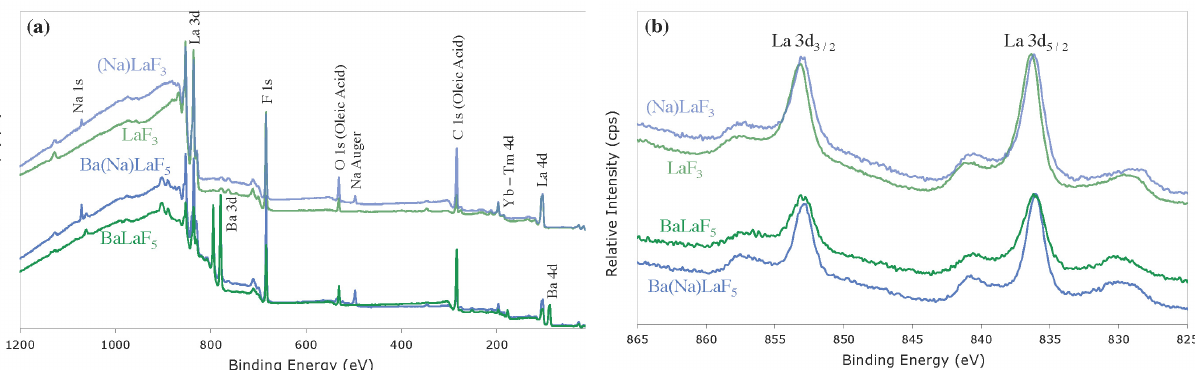
Figure 4. XPS survey scans of ( a1 ) (Na)LaF ( pale Blue ); ( a2 ) LaF ( pale Green ); 3 3 ( a3 ) Ba(Na)LaF ( Blue ); and ( a4 ) BaLaF ( Green ) indicating the presence and absence of 5 5 ( pale Blue ); ( b2 ) LaF Na-codopant; normalized XPS La 3d spectral region ( b1 ) (Na)LaF 3 3 ( pale Green ); ( b3 ) Ba(Na)LaF ( Blue ); and ( b4 ) BaLaF ( Green) indicating a shift in 5 5 binding energy in La 3d core orbital upon Na + 5/2